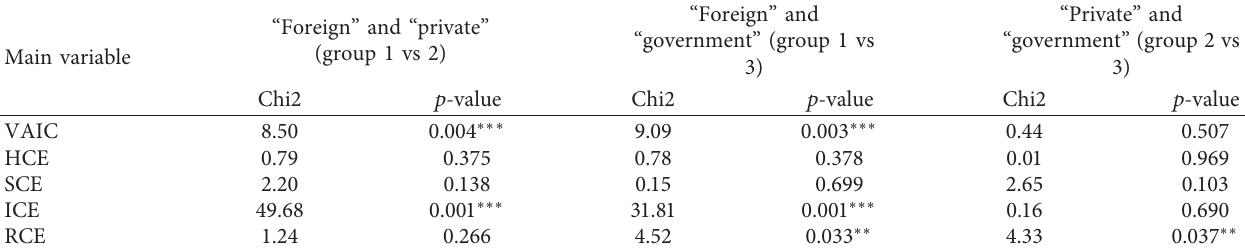
Table 7: SUR-group test (1 vs 2, 1 vs 3, and 2 vs 3) coefficient